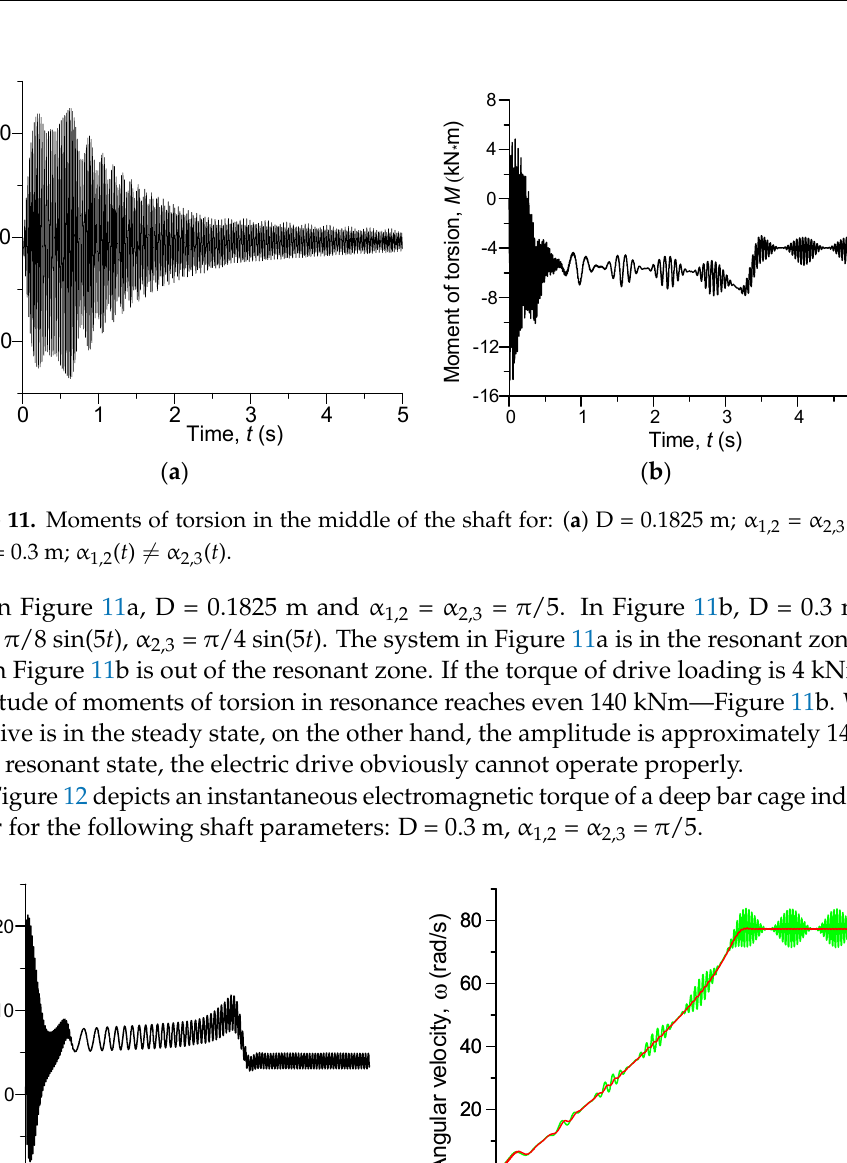
( b ) Figure 10. Angular velocity of motor rotor versus time for α 1,2 = α 2,3 = π /5 and shaft diameter: ( a ) D = 0.3 m; ( b ) D = 0.1825 m.